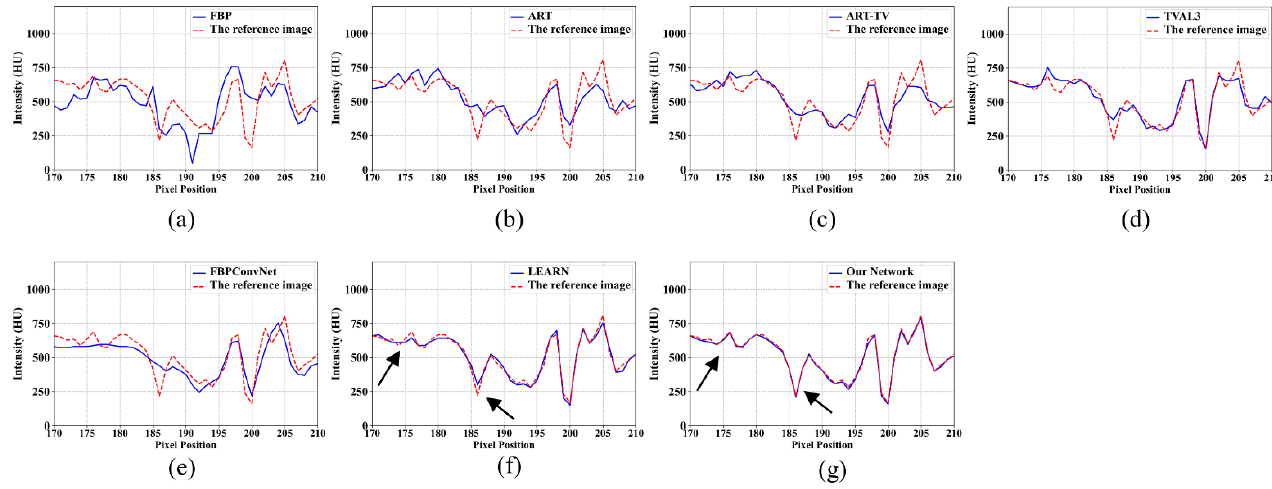
Figure 6. Horizontal profiles along the blue line shown in Figure 5a of the reference image versus the images reconstructed (from 64 views) using ( a ) FBP, ( b ) ART, ( c ) ART-TV, ( d ) TVAL3, ( e ) FBPConvNet, ( f ) LEARN, and ( g ) our network. The differences between our network and the LEARN network are marked by black arrows.